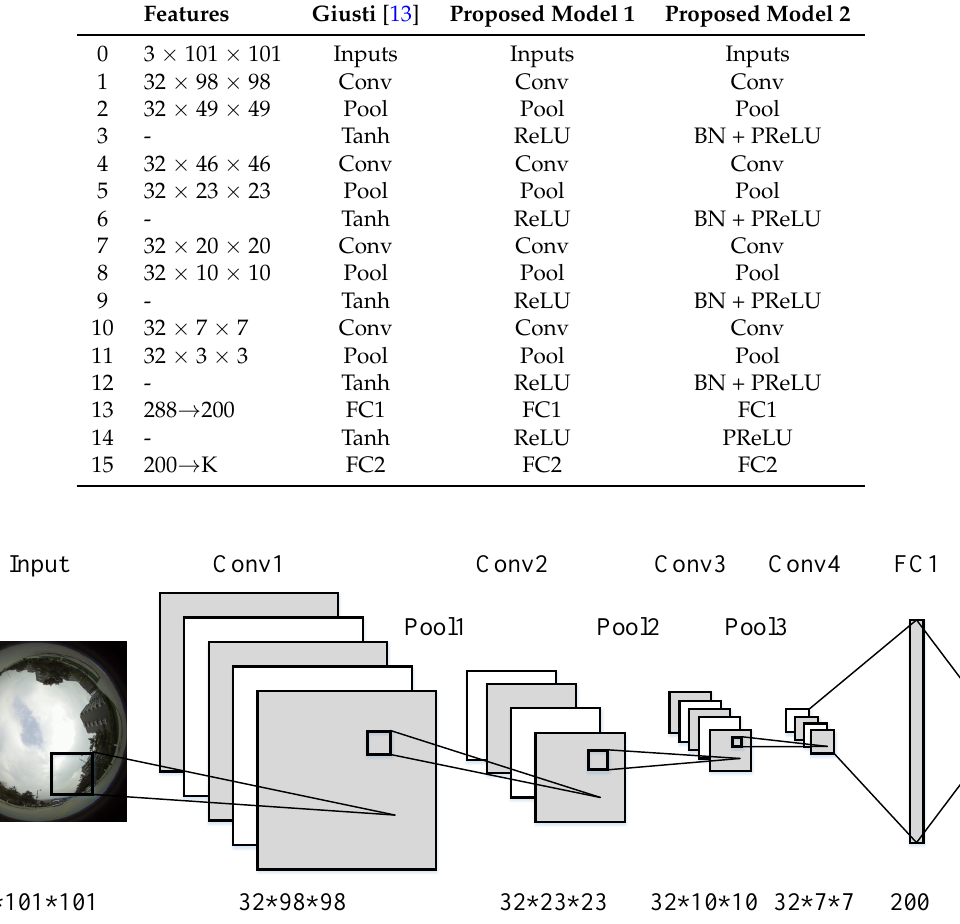
Figure 2. Proposed convolutional neural network based navigation framework. It consists of four convolutional layers, three pooling layers, and two fully connected layers. The inputs are raw, uncalibrated spherical images and the outputs are navigation signals (steering direction and